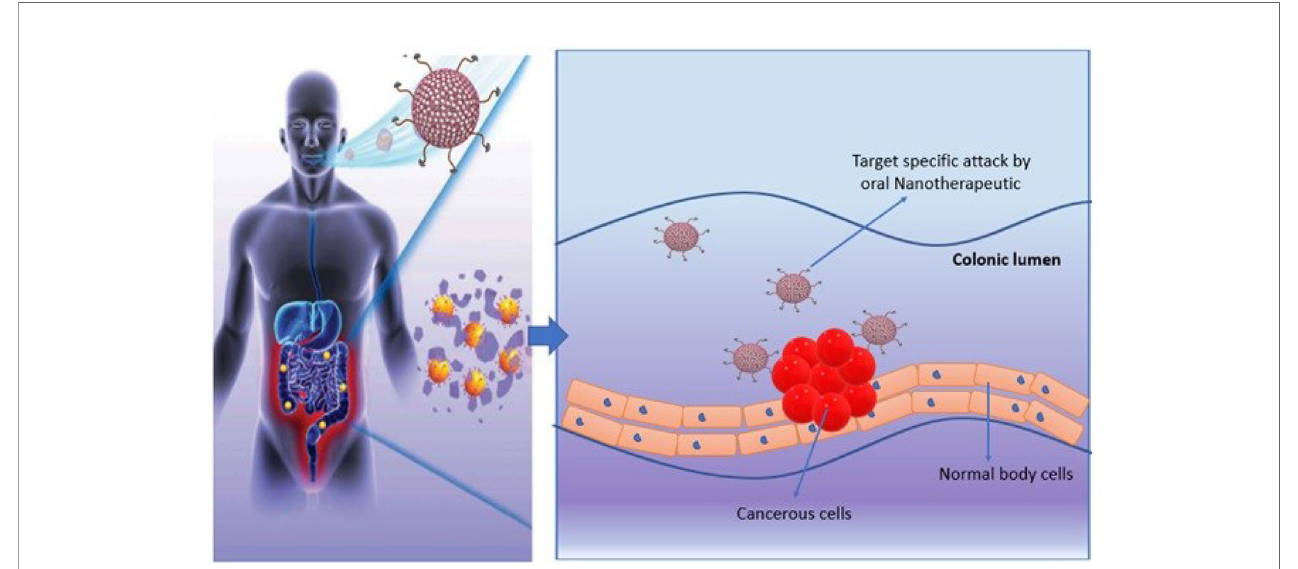
FIGURE 5 | Schematical representation the passage of oral nanotherapeutics to treat colon cancer.